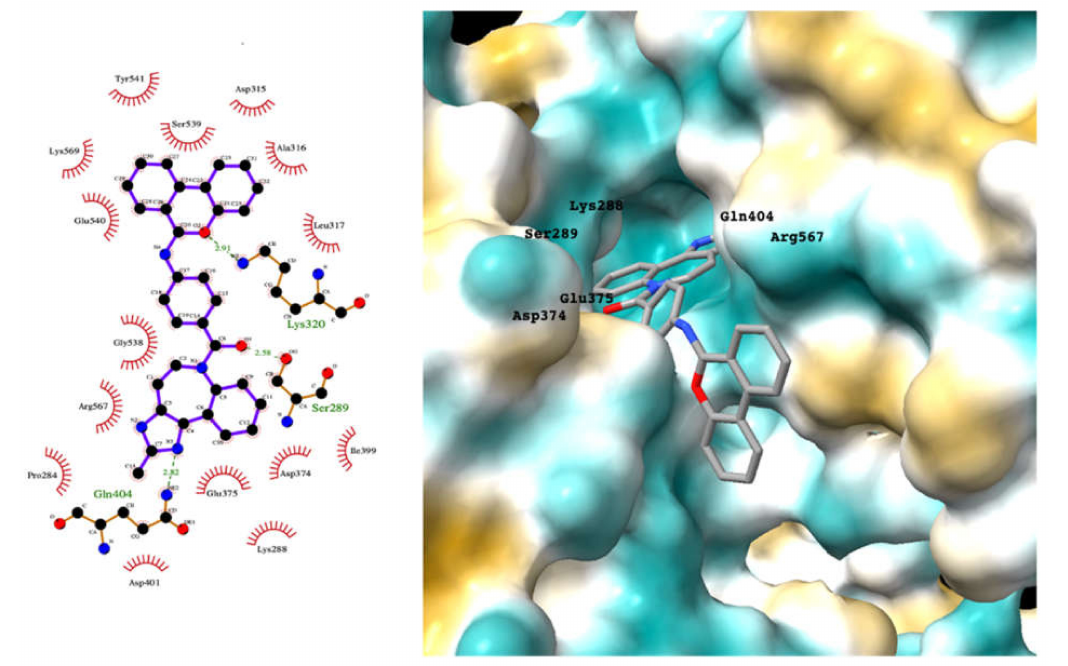
Figure 5. LigPlot ( left ) shows the key active site residues interacting with canivaptan. The molecular model ( right ) shows the binding of canivaptan to the active site cleft of the helicase. The tricyclic ring moiety is deeply embedded in a hydrophilic pocket. The molecular surface denotes hydrophobicity of the pockets (blue hydrophilic, yellow/brown hydrophobic). Positions of key binding site residues are labeled.